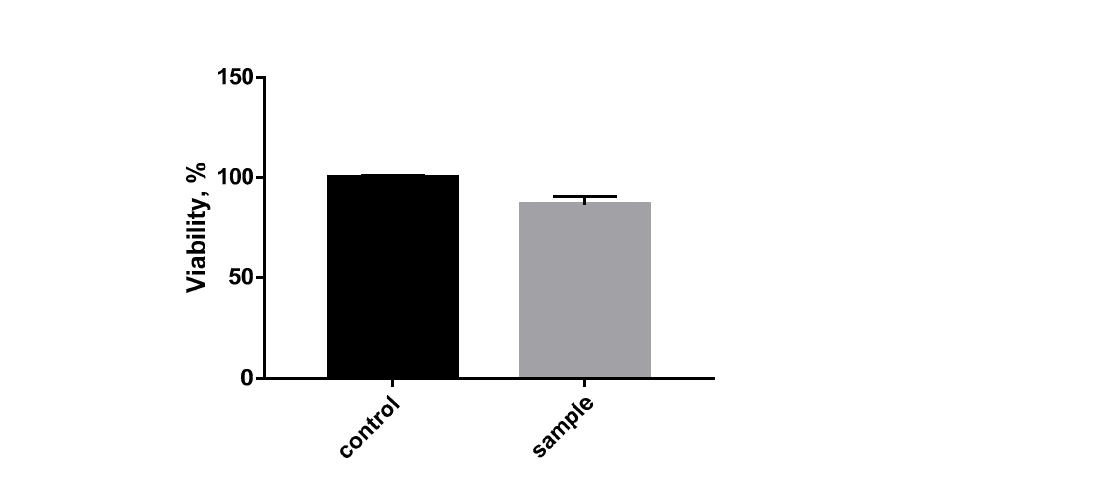
Figure 9. Evaluation of the cytotoxicity of the polymer blend PLA + 10%PCL for a SC1 cell line.